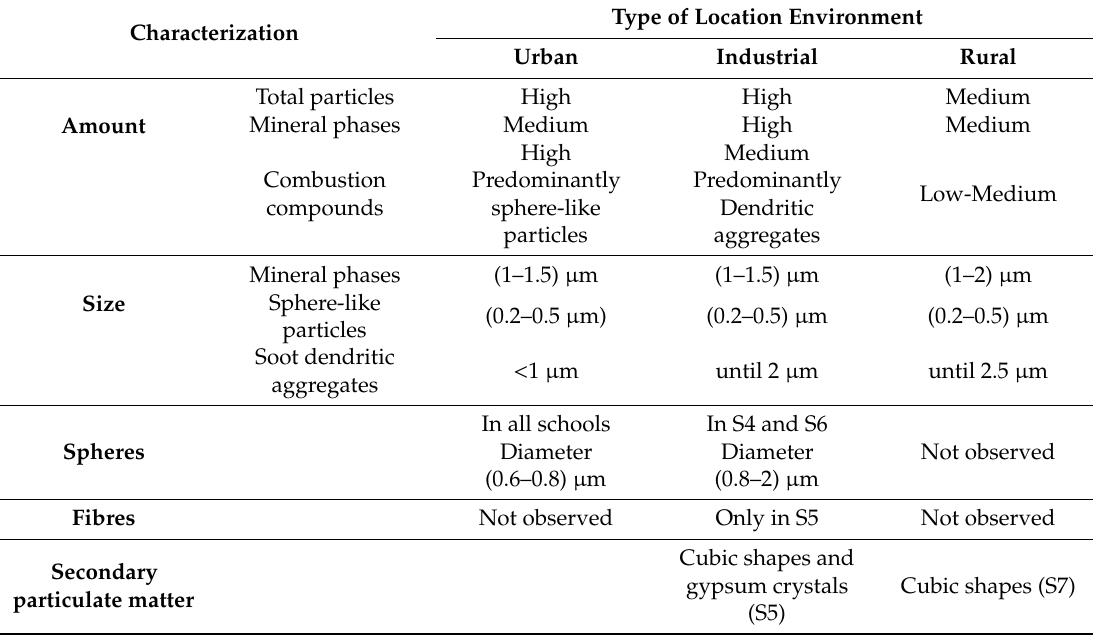
Table 2. Results of fine fraction ( < 2.5 µ m)